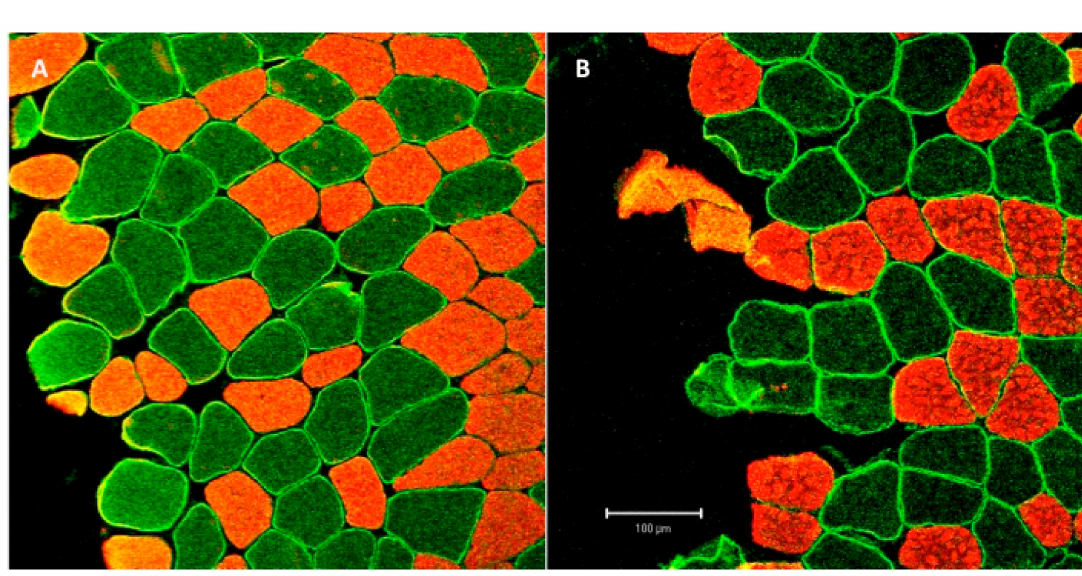
Figure 2. Representative pictures of immunofluorescence stained myofiber cross-sections showing specific MCT-1 and MCT-4 staining (green) and type 1 myofiber staining (red) within membrane and sarcoplasmic areas of myofibers (10 × fold magnification). ( A ) MCT-4 Posttest, ( B ) MCT-1